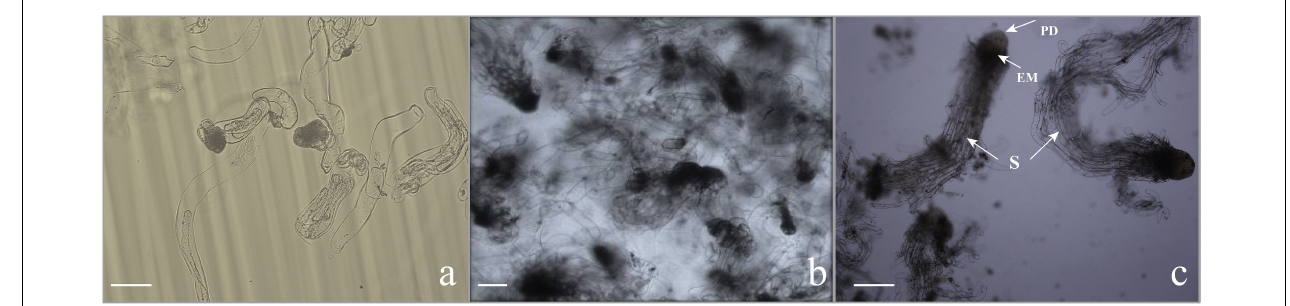
FIGURE 3 | Microscopic characteristics of somatic embryogenesis. (a) Callus in the proliferation stage. The embryonic head of the filamentous embryos was composed of small, dense cytoplasmic cells, and the suspensor apparatus was formed by elongated cells with large vacuoles. Scale bar = 100 µ m. (b,c) Morphology of embryogenic cells growing in the liquid medium subjected to synchronization. (b) Embryos stained with toluidine blue, consisting of the embryo proper and embryo suspensor. Scale bar = 200 µ m. (c) The early somatic embryo consists of a single embryo with a globular compact embryonal mass with a protoderm-like layer and suspensor-like cells (S). Scale bar = 200 µ m.